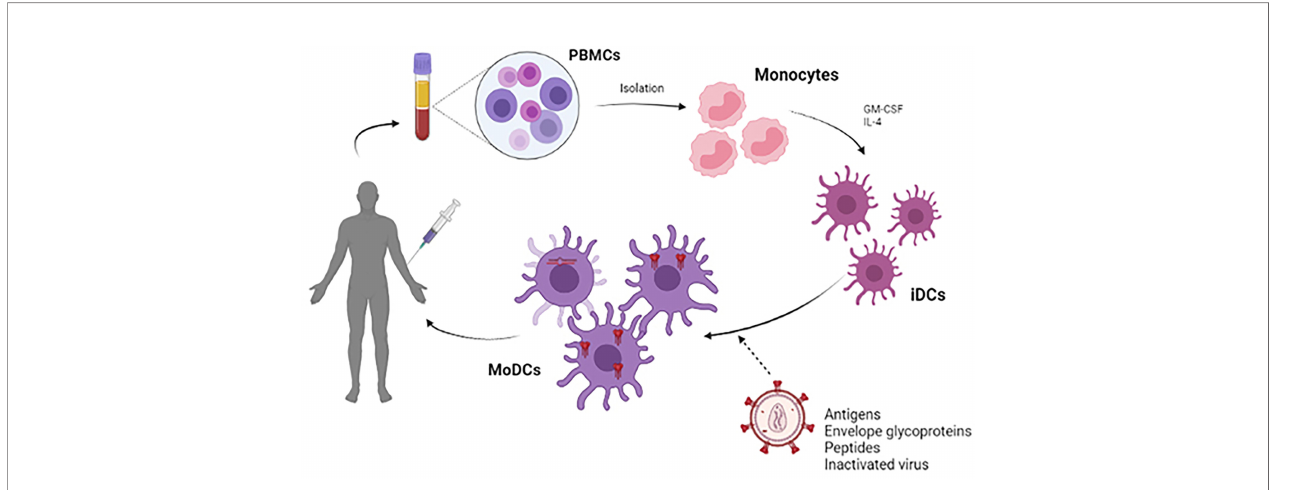
FIGURE 3 | Scheme of the development of a therapeutic vaccine based on DCs. For the development of autologous dendritic cell vaccines, monocytes were extracted from PBMC obtained by leukapheresis from the patient himself. Monocytes are stimulated in vitro with GM-CSF and IL-4 to induce differentiation into immature dendritic cells (iDCs). These iDCs are loaded with HIV-1 derived antigen (antigenic peptides, inactivated whole virus, envelope glycoproteins) and will subsequently become mature antigen-presenting dendritic cells. These MoDCs can be used to formulate a vaccine that is administered to the patient to elicit a speci fi c T-cell response to the HIV-1